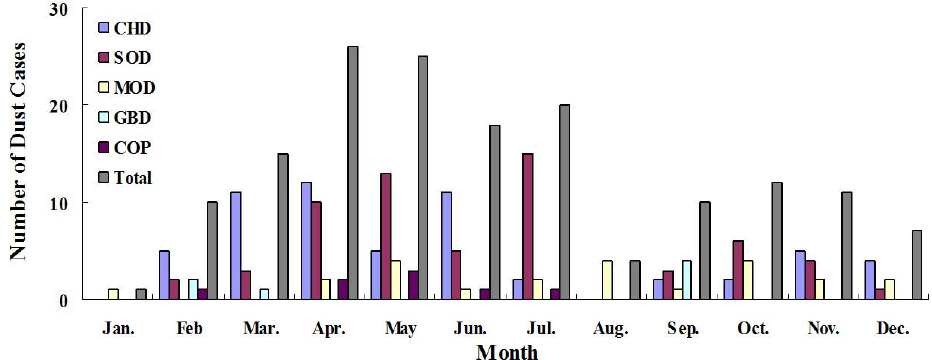
Fig. 7. The monthly frequency of local dust cases from 2000 to 2007 in the five dust source regions, namely, the Chihuahuan Desert (CHD), the Sonoran Desert (SOD), the Mojave Desert (MOD), the Great Basin Desert (GBD) and the Colorado Plateau